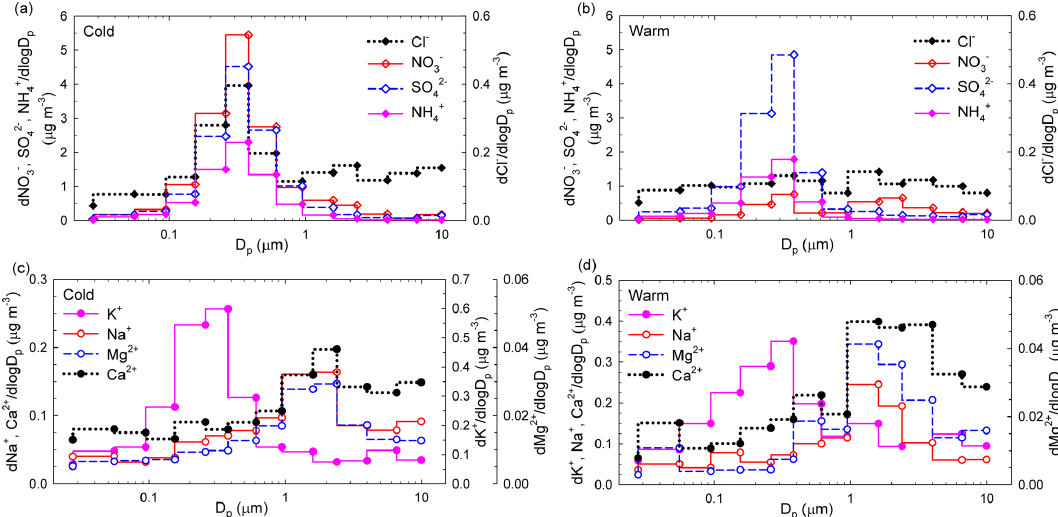
Figure 9. Size distributions of seasonal averaged mass concentrations for Cl − , NO − Ca 2 + (c, d) ions in atmospheric aerosols from Iasi, during both the cold season and the warm season,